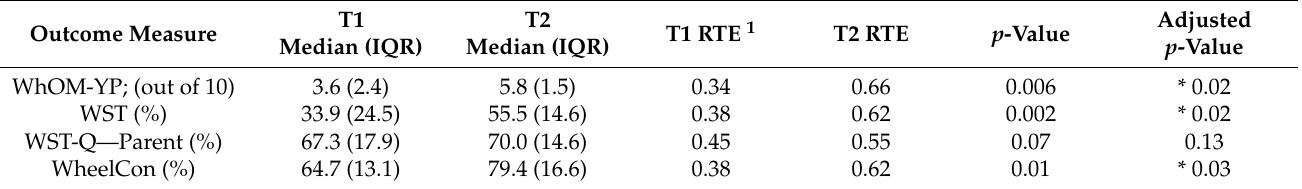
Table 3. Summary of primary and secondary outcomes, RTE as baseline (T1) and post-intervention (T2), and non-adjusted and adjusted p -values.